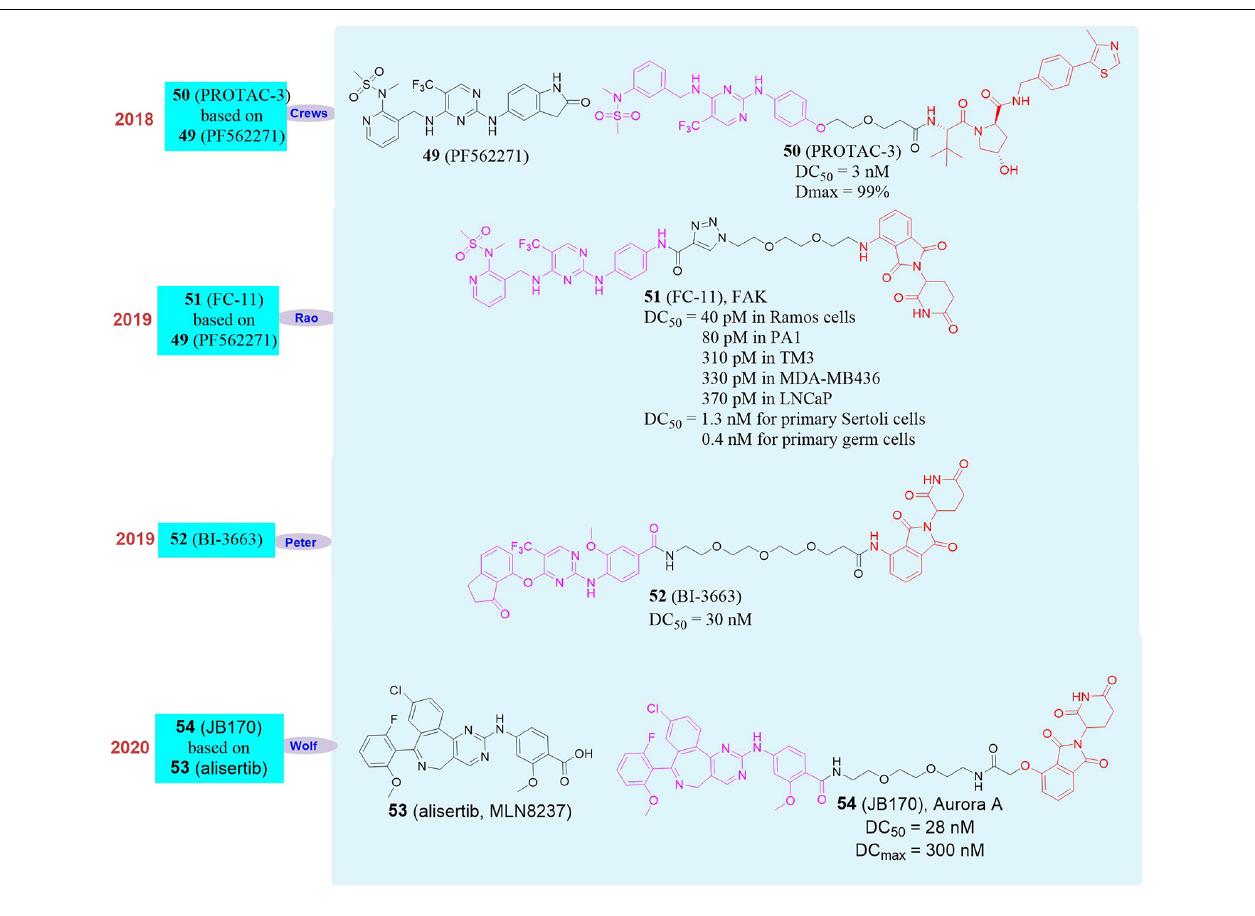
FIGURE 9 | Structures of FAK and Aurora A inhibitors and